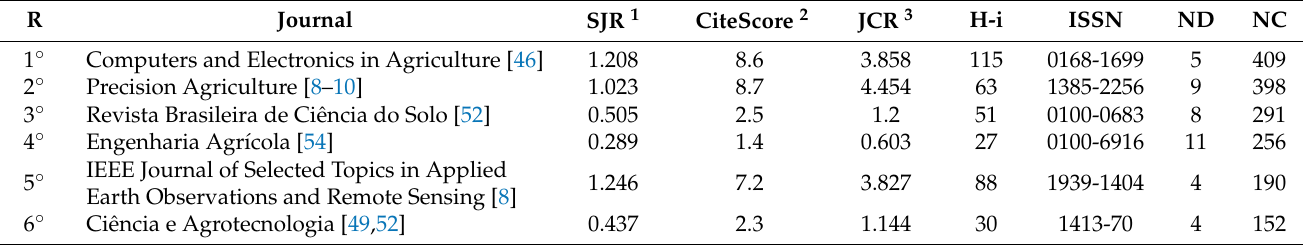
Table 2. Top 6 sources of publications in word on precision coffee growing from 2000 to 2021/1st sem.